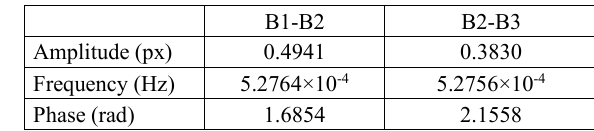
Table 3. Parameters of the disparity curve The parallax disparities are fitted by the sine function and parameters of the fitted disparity curve are listed in Table 3. The distances vary between multispectral bands, resulting in different imaging intervals of corresponding lines in each band, so that parallax obtained with different bands is different. Hence, the amplitude or phase obtained by using B1-B2 varies from that obtained with B2-B3 bands, and only the frequency is similar. According to the integration imaging model, the disparity curve is transferred to the jitter curve, as shown in Table 4. The jitter with amplitude, frequency, phase in terms of approximately 0.9 px, 0.6 Hz and -0.1 rad is detected, where the deviation between B1-B2 and B2-B3 is no more than 0.0567 px, 0.0001 Hz and 0.0004 rad. The small deviation indicates that the presented method is reliable.